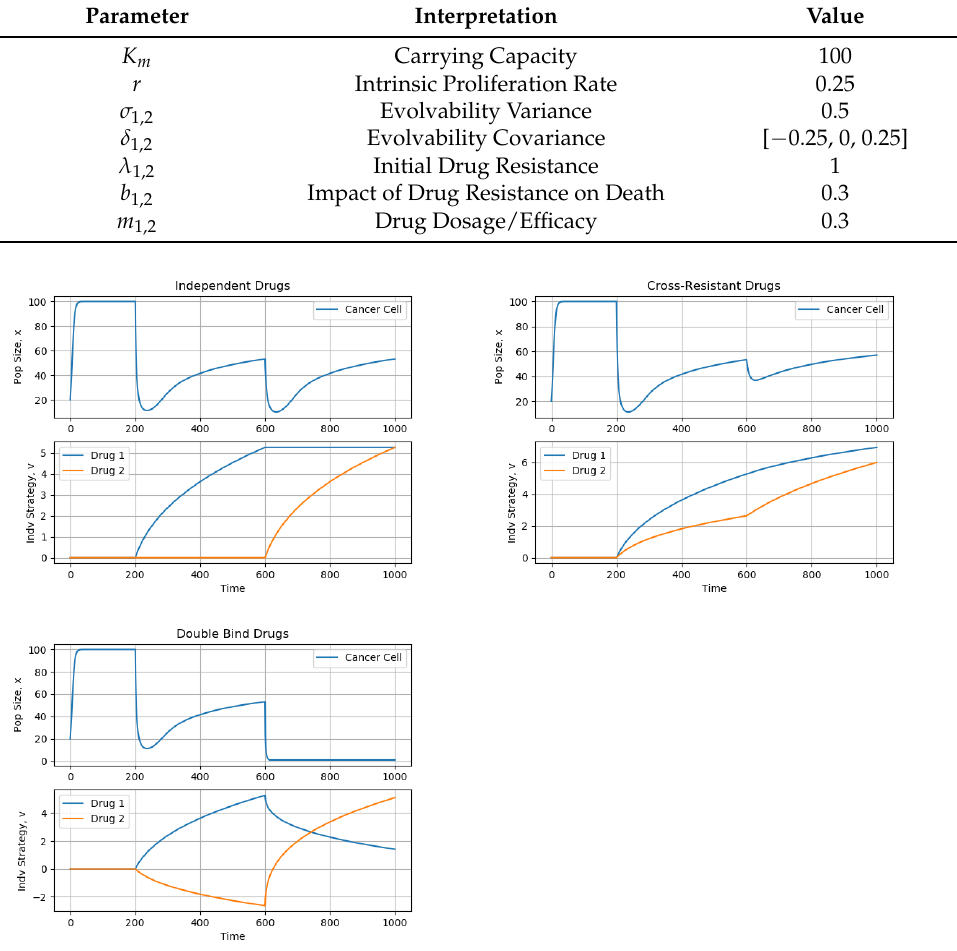
Figure 6. Effects of Independent, Cross-Resistant, and Double Bind Drugs on Cancer Cell